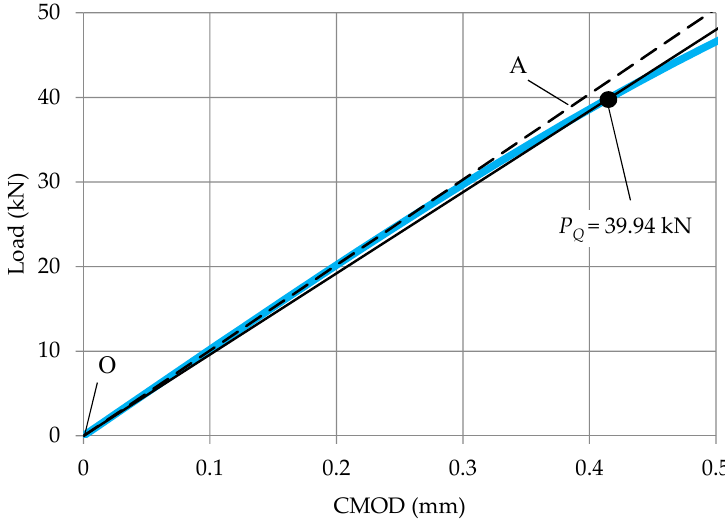
Figure 7. Determination of P Q load for the as-received specimen at room temperature.